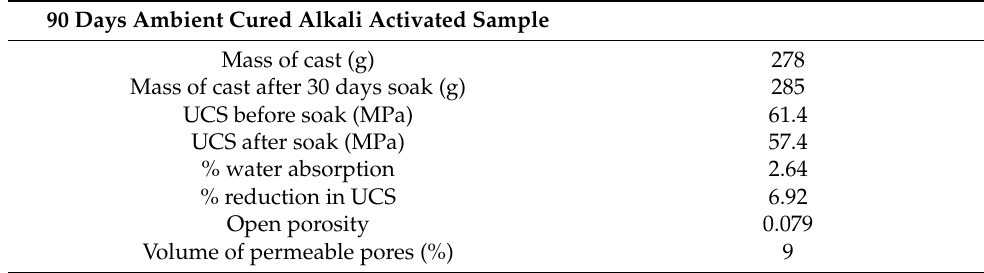
Table 4. 30 days-soaked alkali activated specimen properties.